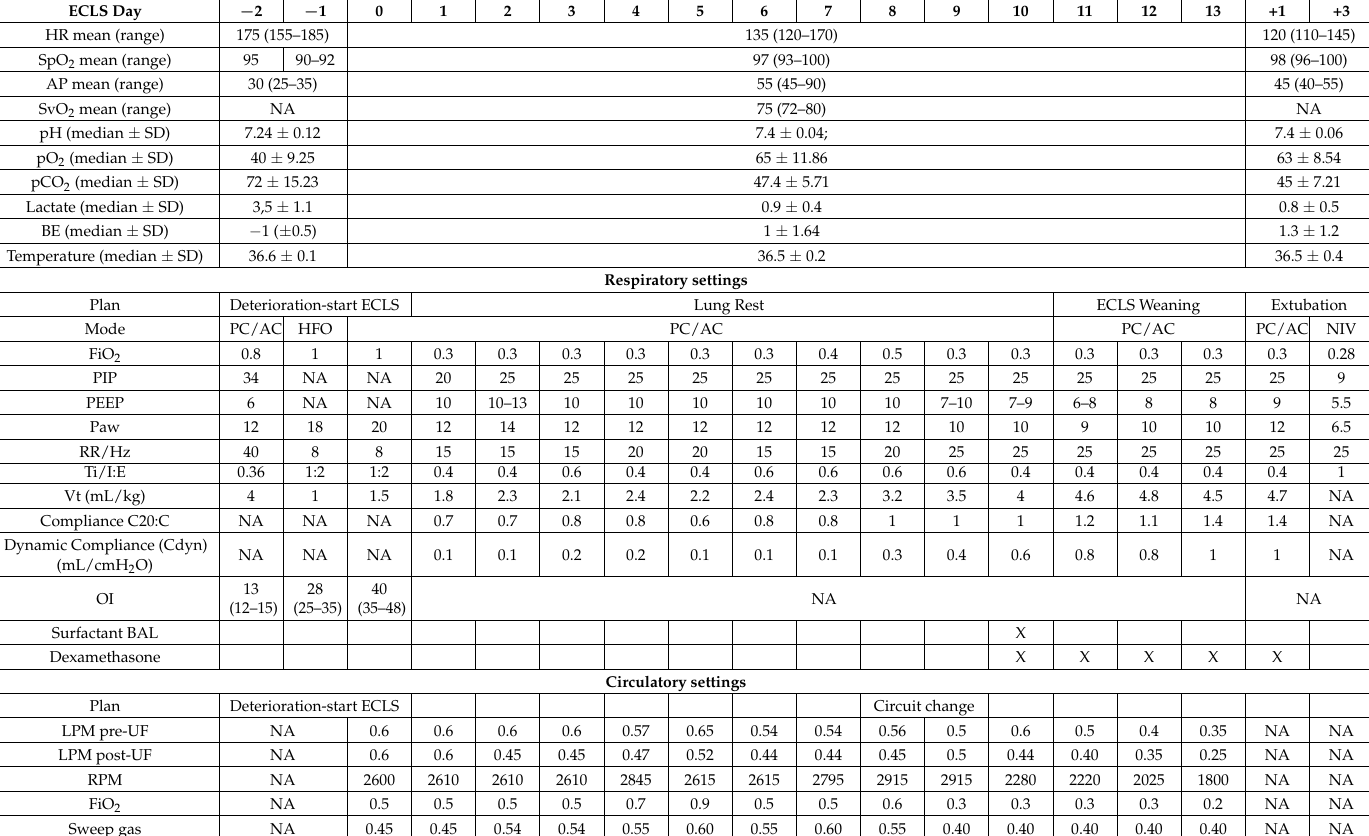
Table 1. Main respiratory and hemodynamic settings before, during and after extracorporeal life support (ECLS)